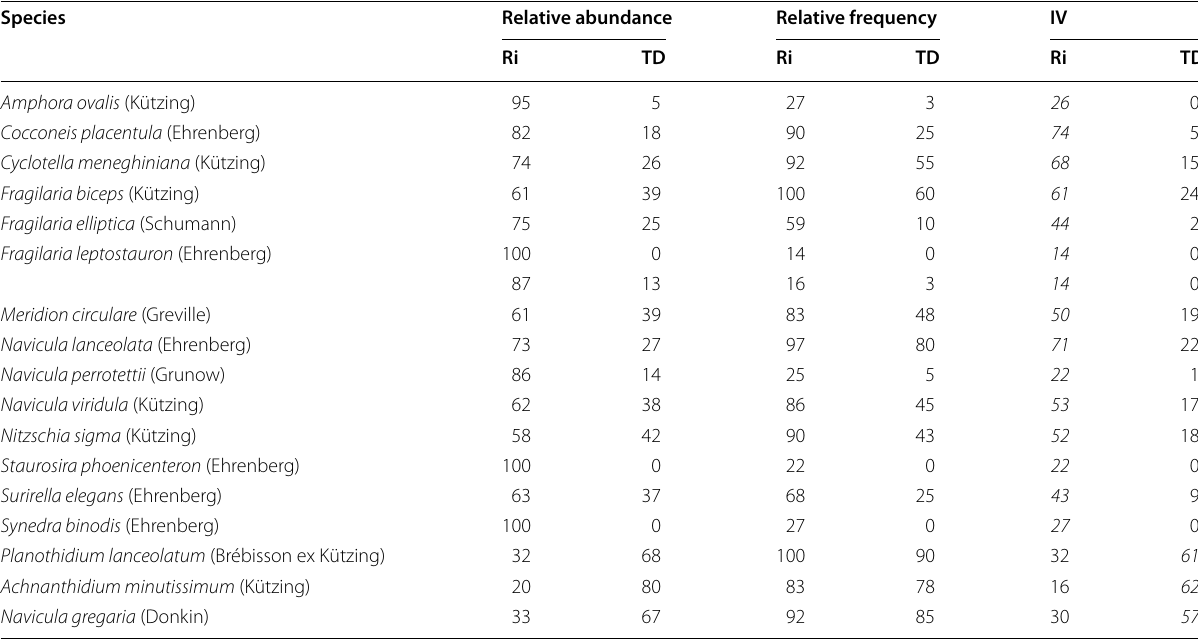
Table 3 Summary of indicator species analysis showing indicator taxa, relative abundance, relative frequency, and indi- cator value (IV) for each